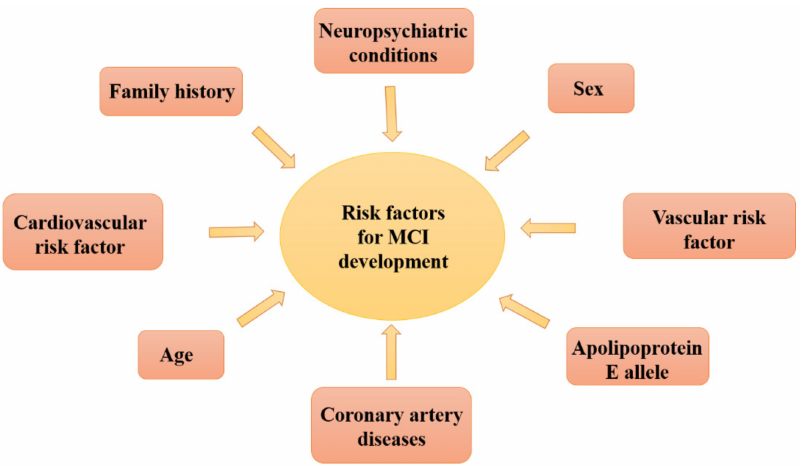
Figure 1. Risk factors for MCI development.